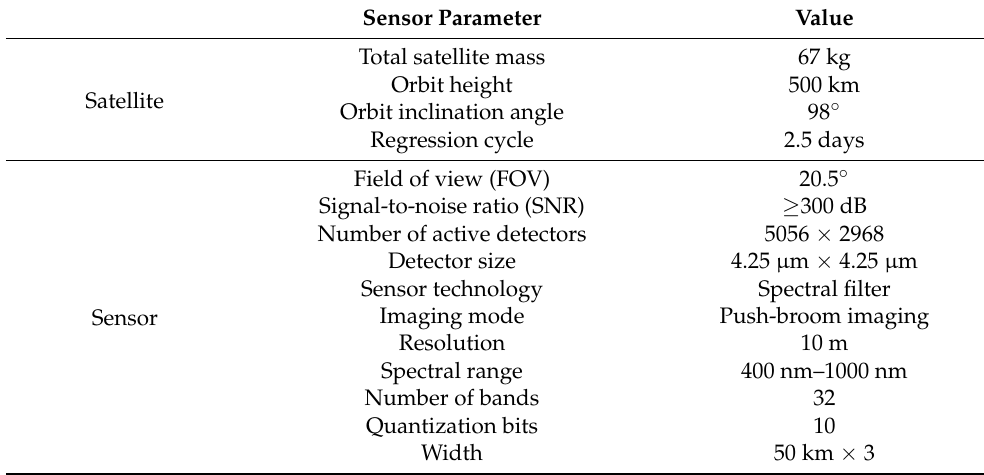
Table 1. Sensor parameters of